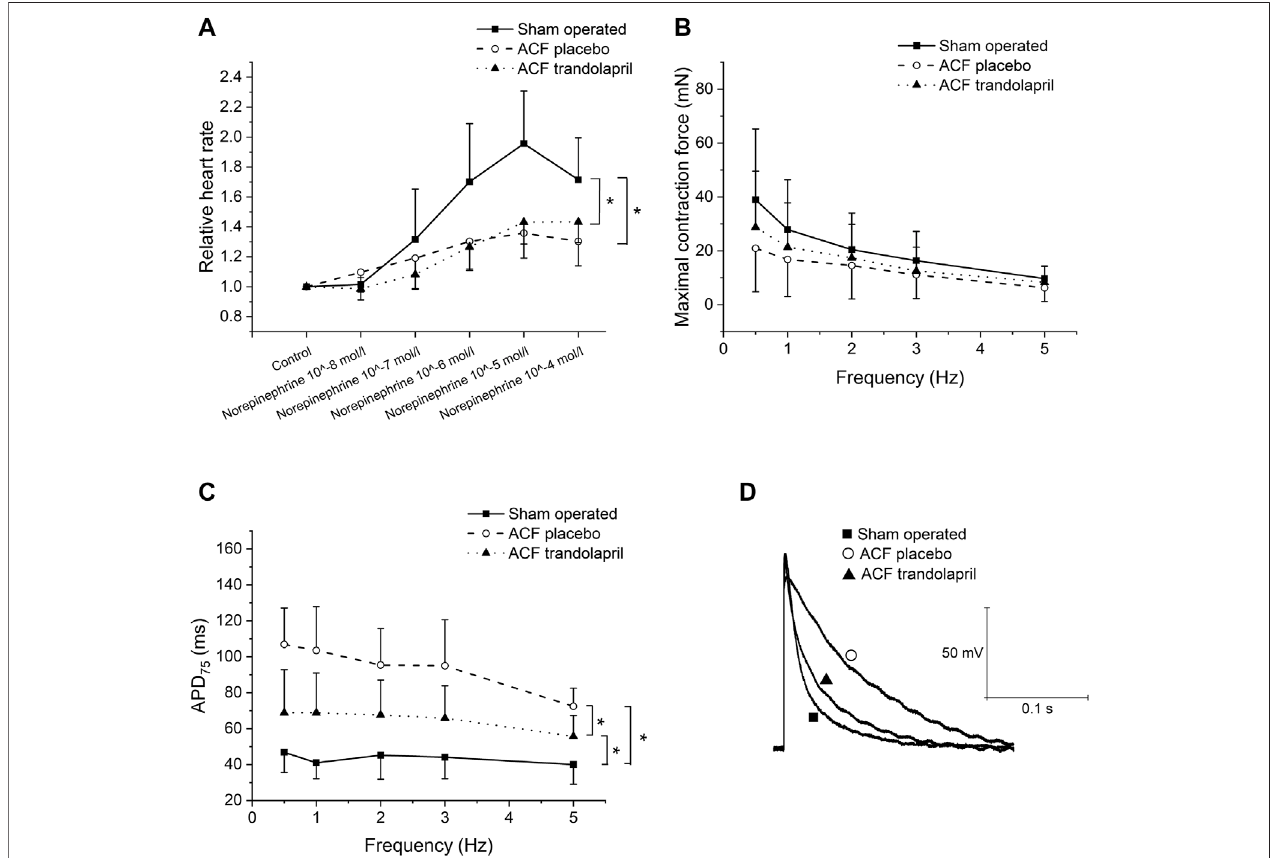
FIGURE 4 | Isolated cardiac tissue. (A) Effect of norepinephrine on spontaneous activity of isolated atria from sham-operated rats ( n (cid:1) 12), ACF rats ( n (cid:1) 10) and ACFratswithtrandolapril( n (cid:1) 10). (B) Contractionforceinleftventricletrabeculaeofsham-operatedrats( n (cid:1) 12),ACFrats( n (cid:1) 10)andACFratswithtrandolapril( n (cid:1) 10). (C) Action potential duration at 75%repolarization (APD 75 ) inleft ventricletrabeculaeofsham-operatedrats ( n (cid:1) 12), ACFrats( n (cid:1) 10) and ACF ratswithtrandolapril( n (cid:1) 10). (D) Representative cellular action potentials in left ventricle trabeculae of a sham-operated rat, an ACF rat, and an ACF rat with trandolapril at stimulation frequency of 1 Hz. * p <